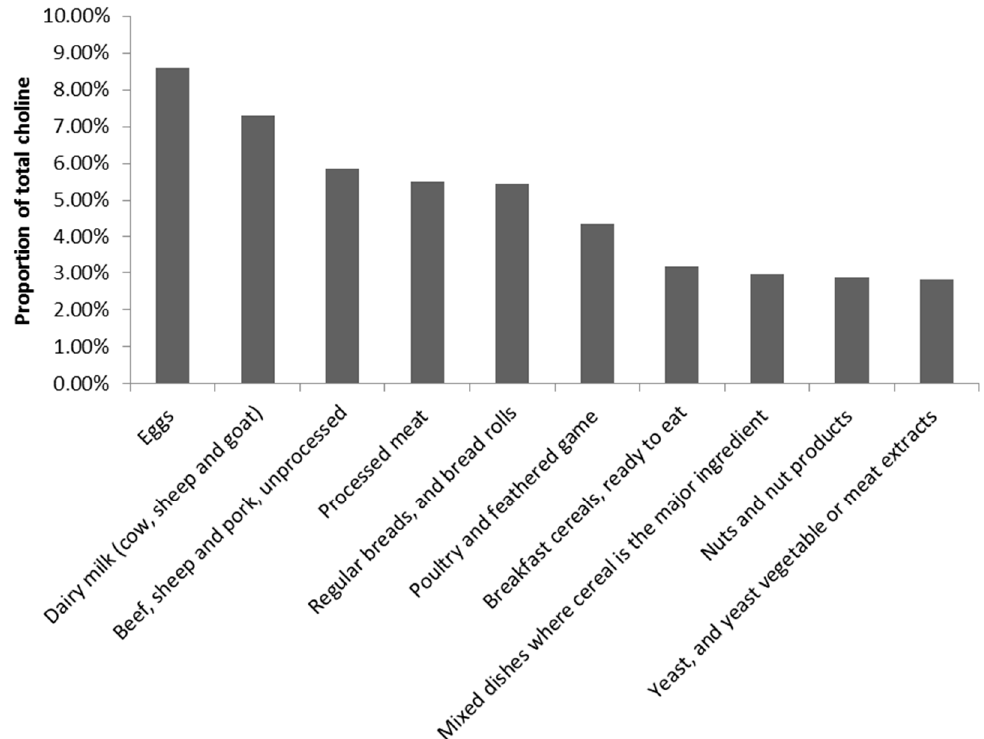
Figure 1. Food group contributors to Australian choline intakes 1 . 1 Food groups equate to 48.83% of total choline intake. The remaining 51.17% of contributions were from food groups including, but not limited to, cheese, dishes where egg is the major component, mixed dishes, where poultry or feathered game is the major component, potatoes, cakes, muffins, scones, cake-type desserts, missed dishes, where beef, sheep or mammalian game is the major component, chocolate and chocolate-based confectionery, pastries, fin fish, fishes where vegetable is the major component. The top 20 food groups equate to 68.45% of the total choline intake.